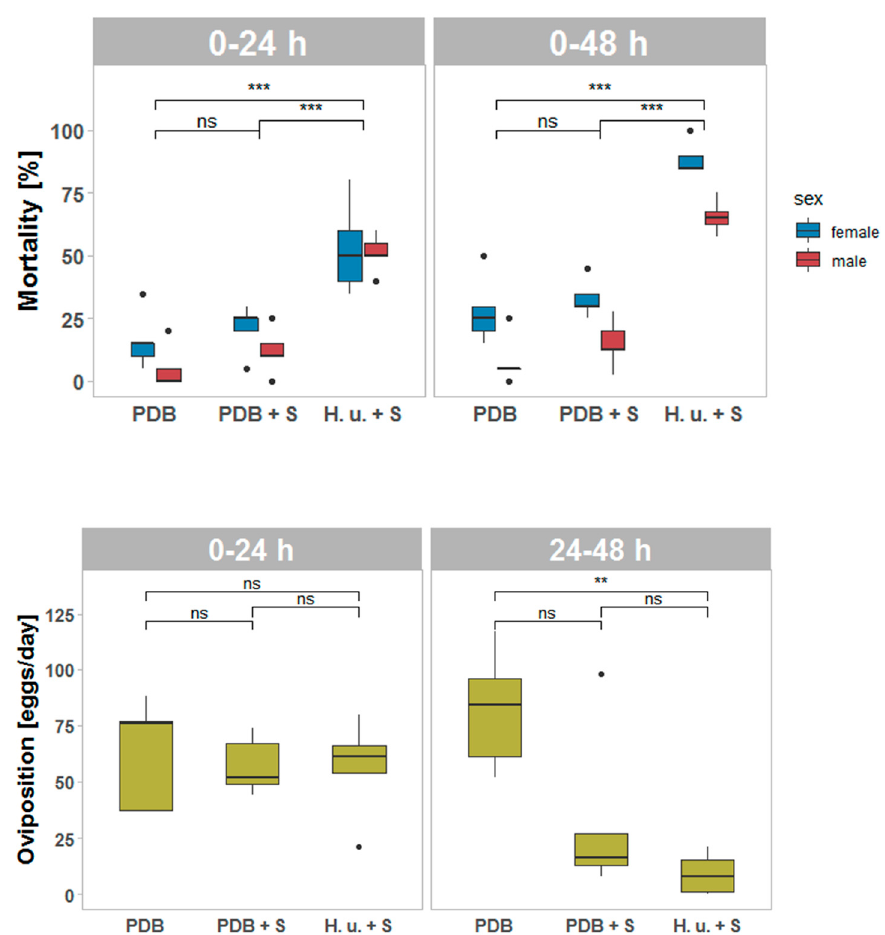
Figure 2. Mortality and oviposition ( n = 5) of spotted wing drosophila (SWD) adults (20 males and 20 females) after the exposure to leaves treated with potato dextrose broth (PDB), PDB plus spinosad (PDB + S), or H. uvarum plus spinosad (H. u. + S) one day after treatment (T1). Mortality of males and females after 24 h and after 48 h of exposure. Oviposition after the first 24 h and between 24 and 48 h of exposure. Asterisks indicate significant di ff erences between the treatments ( p < 0.05). Not significant di ff erences are reported, as well (ns). Outliers are indicated with dots. ≤ 0.01 = **; ≤ 0.001 =